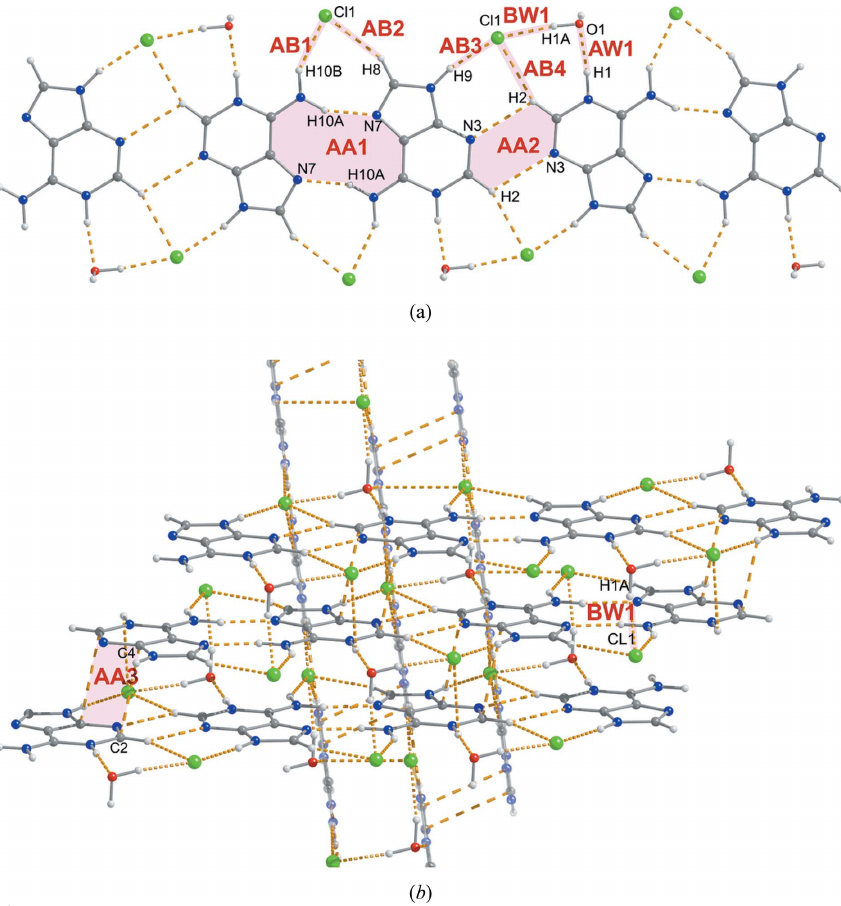
Figure 3 Dimeric motifs in the adeninium chloride hemihydrate (ACH)